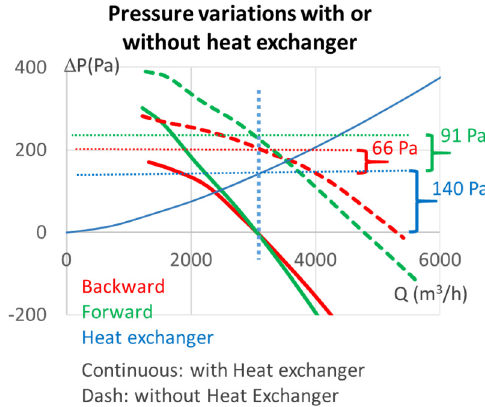
Figure 7. Differences between theoretical pressure losses in the heat exchanger and observed pressure variations by integration in the cooling module.